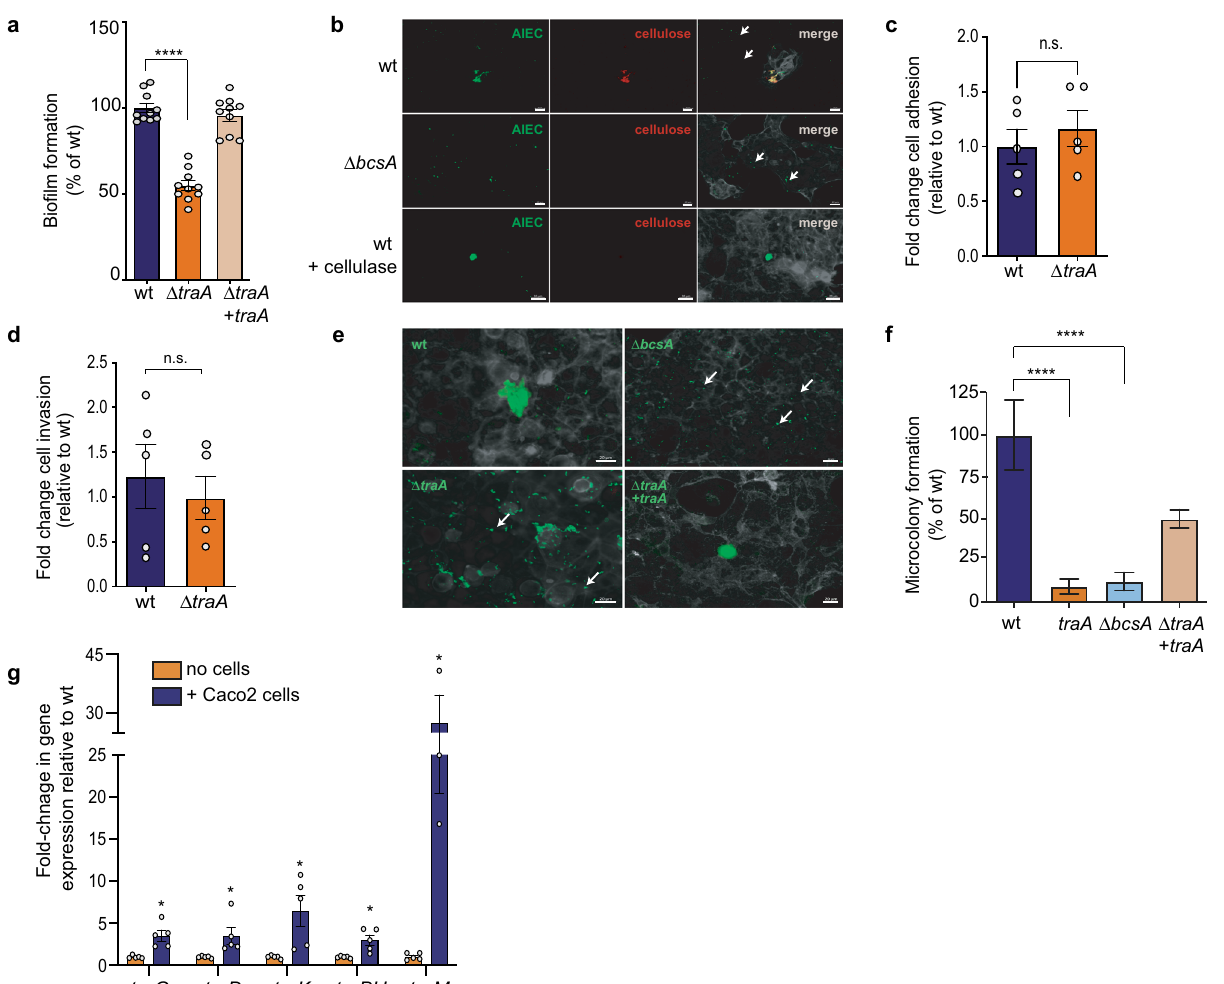
Fig. 4 T4SS promotes bio fi lm formation by AIEC on epithelial cells. a Bio fi lm formation by different AIEC strains on abiotic surfaces. Data are mean change ± SEM in the percentage of bio fi lm formation relative to wild type; n = 10 biologically independent replicates examined over three independent experiments. Groups were compared using two-tailed Mann – Whitney U test, **** P < 0.0001 b Cellulose secretion by AIEC microcolonies. Immuno fl uorescence staining of Caco-2 cells infected with wild-type or Δ bcsA AIEC strains. Right panel, cellulose (red); middle panel, bacteria (green); left panel, merge of both panels showing Caco-2 cells (gray). White arrows indicate individual bacteria. Scale bar is 20 µ m. Panels are representative of 15 images per group obtained from three biologically independent replicates. c traA is not required by AIEC to adhere to epithelial cells. Data are mean change ± SEM in adhesion relative to wild-type strain; n = 5 biologically independent replicates obtained from two independent experiments. Groups were compared using unpaired two-tailed t -test. d traA does not affect cell invasion by AIEC. Cell adhesion and invasion were quanti fi ed for the different AIEC strains indicated. Data are the mean fold change± SEM in invasion relative to wild-type strain; n = 5 biologically independent replicates obtained from two independent experiments. Groups were compared using unpaired two-tailed t -test. e Immuno fl uorescence staining of different AIEC strains (green) showing microcolonies on epithelial cells (gray). White arrows indicate individual bacteria. Panels are representative of 20 images per group; n = 3 biologically independent replicates. Scale bar is 20 µ m. f Microcolony formation was quanti fi ed using 20 fi elds of view per all groups except bcsA (23 fi elds of view); n = 3 biologically independent replicates. Data are the mean ± SEM microcolony formation relative to wild-type strain. Groups were compared using two-tailed Mann – Whitney U test, **** P < 0.0001. g Fold change in gene expression of different tra genes in AIEC wild-type strain upon infecting Caco-2 cells; n = 5 biologically independent replicates ( n = 3 for traM ) obtained from two independent experiments. Groups were compared using Holm – Sidak method for multiple t -tests (two-tailed). Adjusted P values are 0.016645 for traG , 0.03507 for traD , 0.033591 for traK , 0.027143 for traBH , and 0.010832 for traM